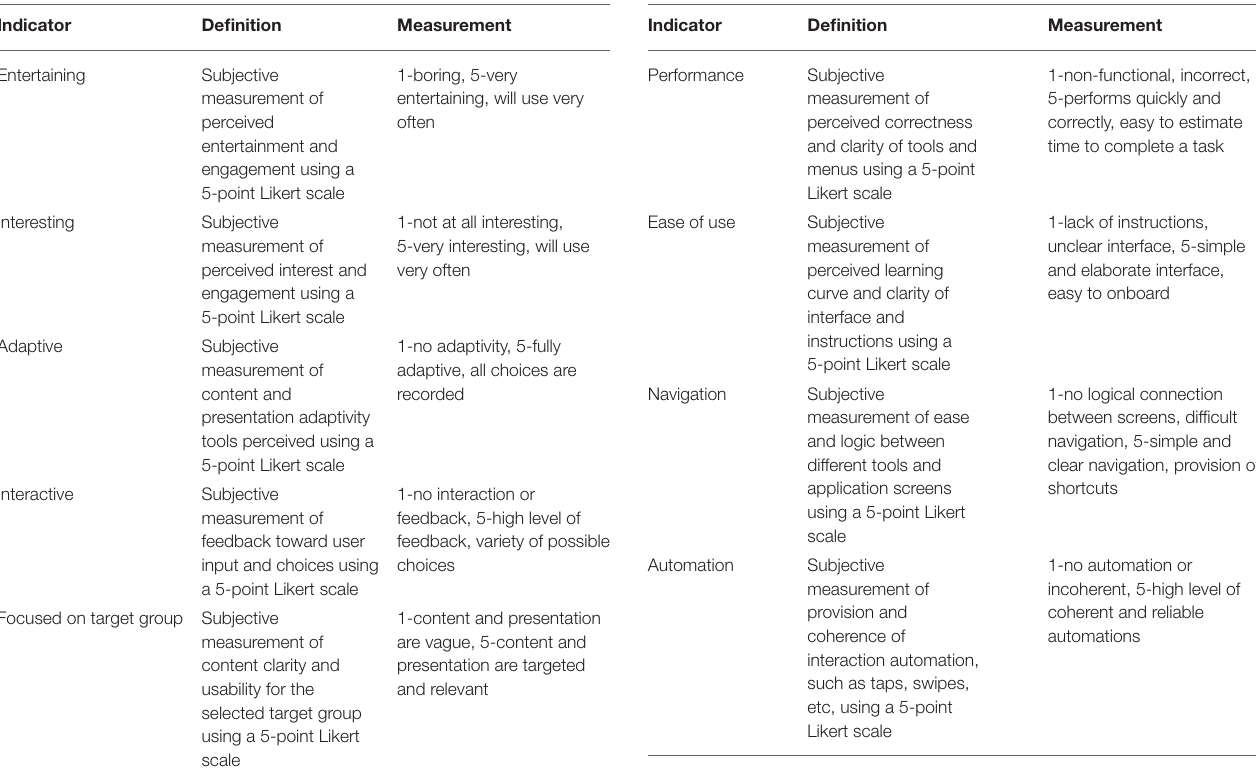
TABLE 1 | Engagement measurements. TABLE 2 | Functionality